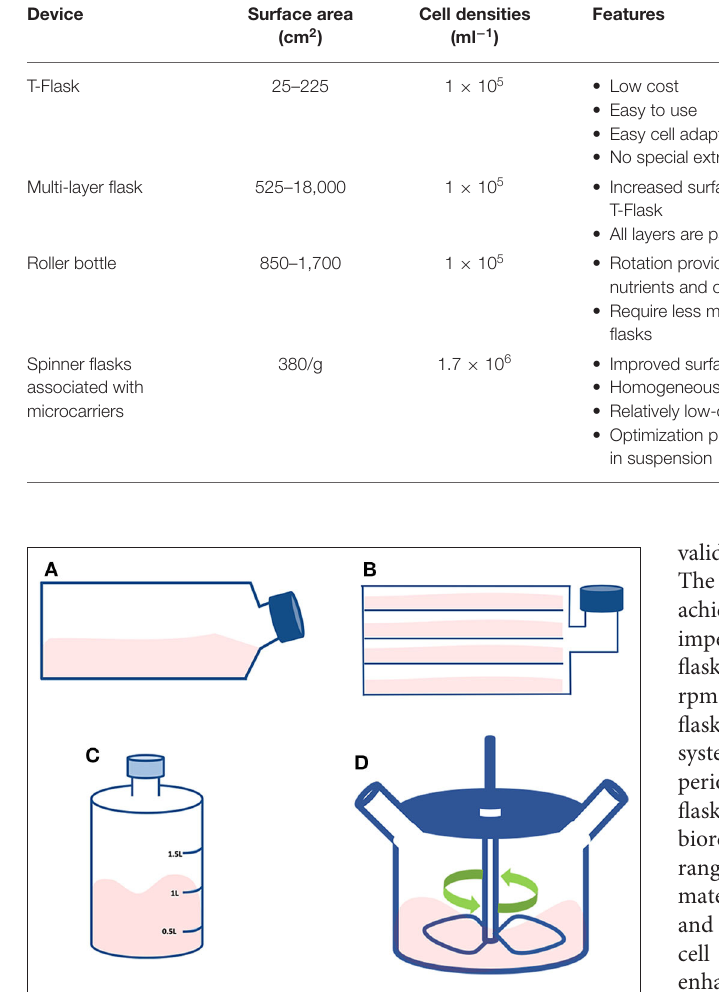
FIGURE 5 | Small scale technologies. Schematic representing the discussed compact technologies: (A) T-flask; (B) Multi-layered flask; (C) Roller bottle; and (D) Spinner